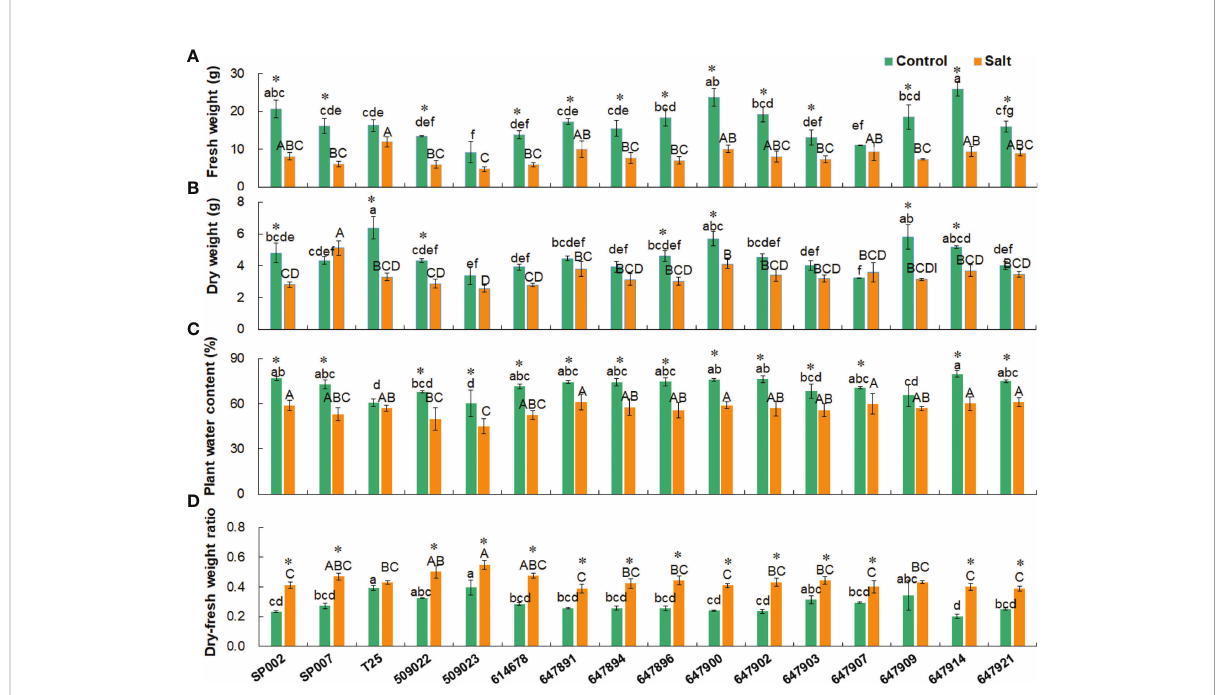
FIGURE 4 Effect of salt stress on shoot biomass parameters of 16 seashore paspalum ecotypes. Shoots were sampled for measurement of fresh weight (A) , dry weight (B) , water content (C) , and dry- fresh weight ratio (D) before treatment (control) and after NaCl treatment for 10 d (salt). Means of three independent experiments and standard errors are presented; the same letter above the column indicates no signi fi cant difference at P <0.05. Lowercase letters and uppercase letters respectively indicate signi fi cant comparisons among different ecotypes in the control group and treatment group. * indicates signi fi cant difference at P <0.05 by T-test between salt treatment and control for 16 ecotypes.